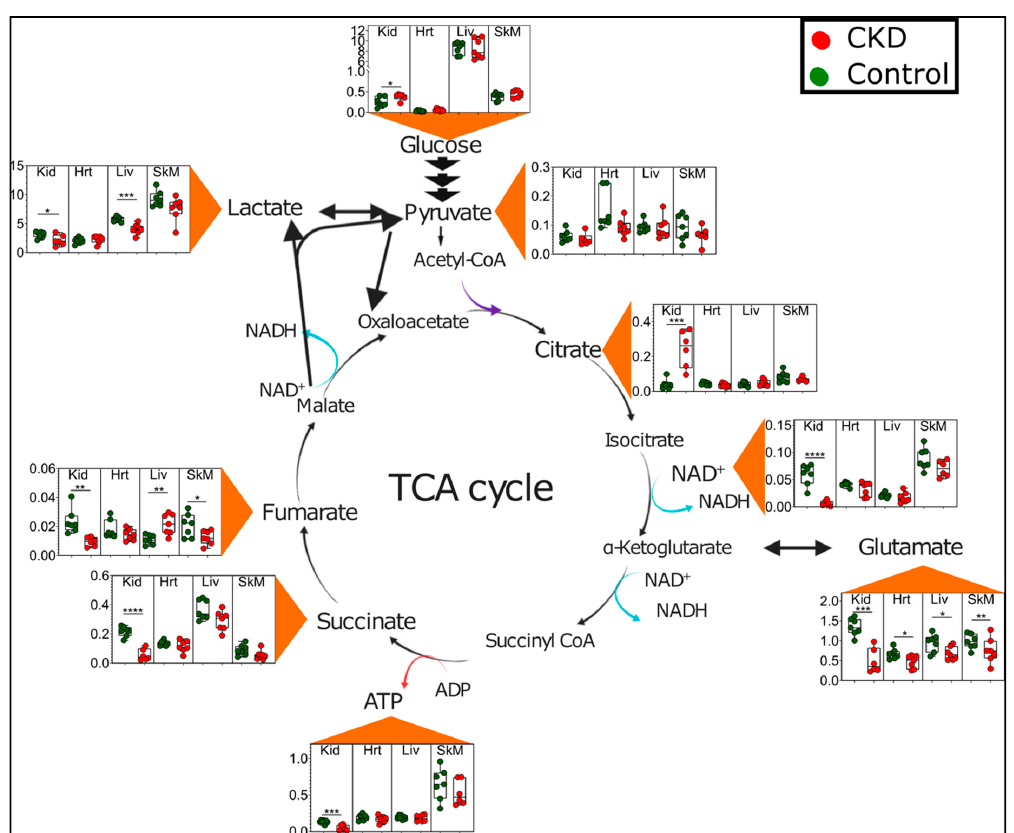
Figure 6. Energetic and tricarboxylic acid (TCA) cycle metabolite disturbances in CKD. Graphical depiction of the TCA cycle with quantified metabolites presented as Box and Whisker plots (showing 95% confidence intervals) in control (green dots) and CKD mice (red dots). The y -axis values represent metabolite concentrations in units of millimolars. A two-tailed unpaired t -test was performed to determine the statistical significance, with * p < 0.05, ** p < 0.01, *** p < 0.001, and **** p < 0.0001. Abbreviations: Kid = kidney, Hrt = heart, Liv = liver, and SkM = skeletal muscle.